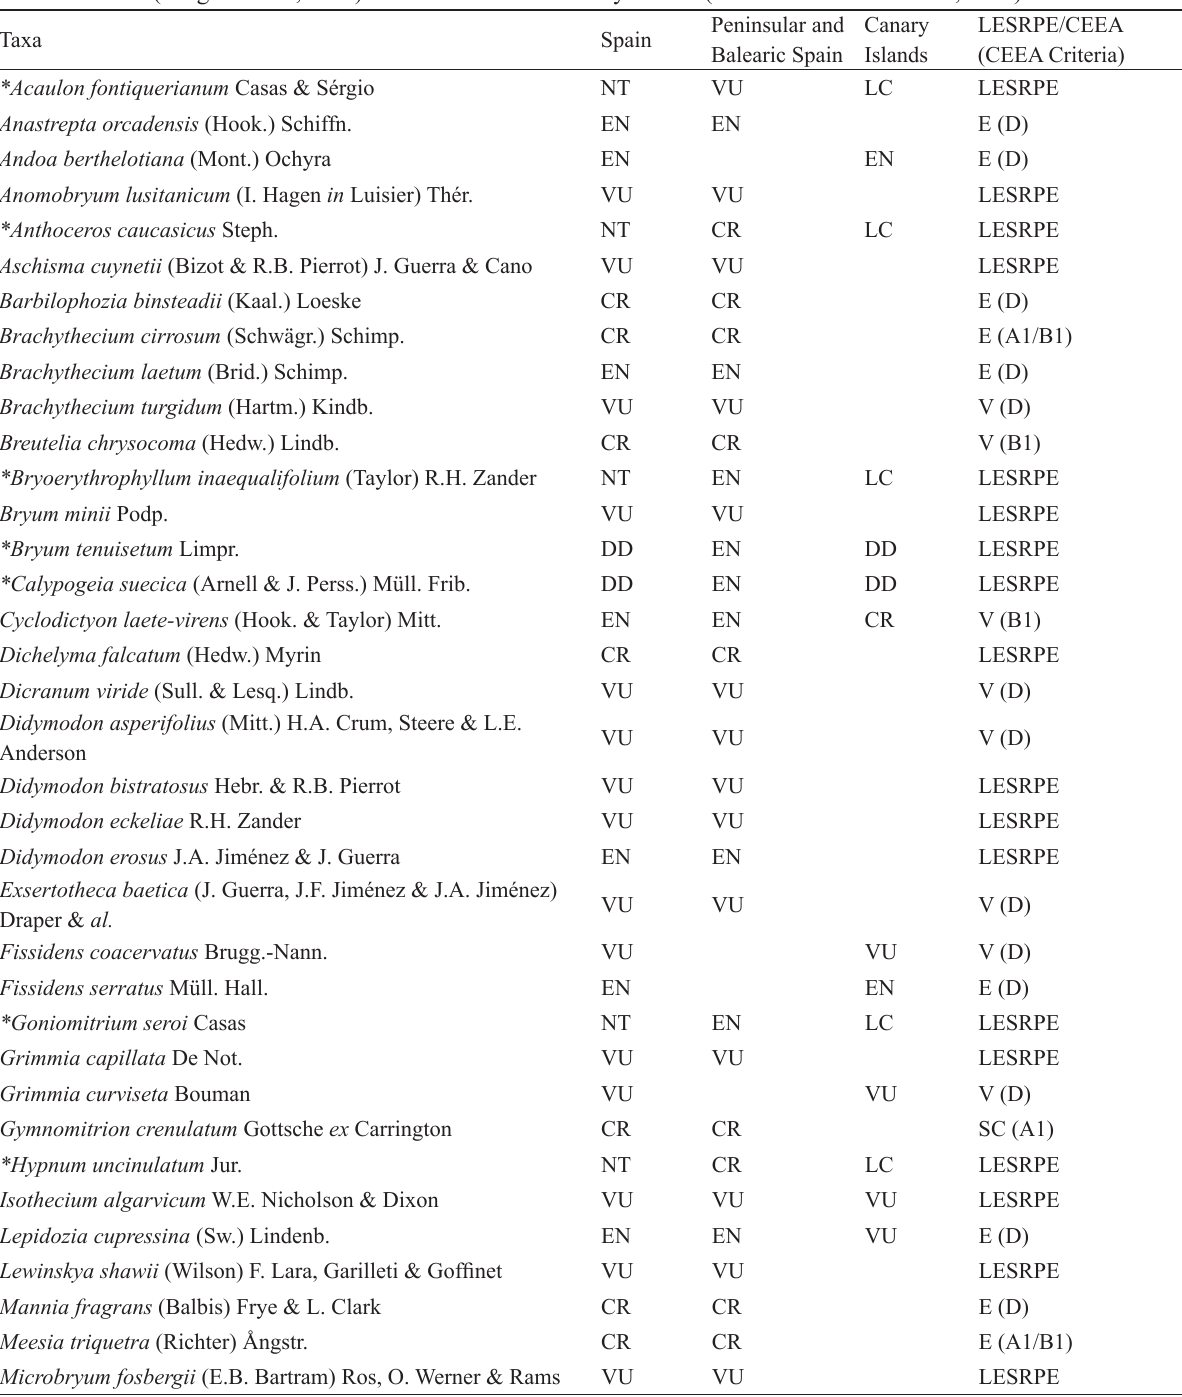
Table 5. List of bryophyte species proposed for inclusion in the national catalogues for species protection LESRPE and CEEA. Species marked (*) are those for which only peninsular and Balearic populations are proposed to protect —not the populations in the Canary Islands, as in this territory they are not threatened—. Categories at CEEA are E (Endangered), V (Vulnerable) and SC (Critical Situation). Criteria used for assignment of categories are in brackets. IUCN categories according to Red List of Spain (Brugués & González-Mancebo, 2014), Red List of peninsular Spain and Balearic Islands (Brugués & al ., 2014) and Red List of the Canary Islands (González-Mancebo & al .,